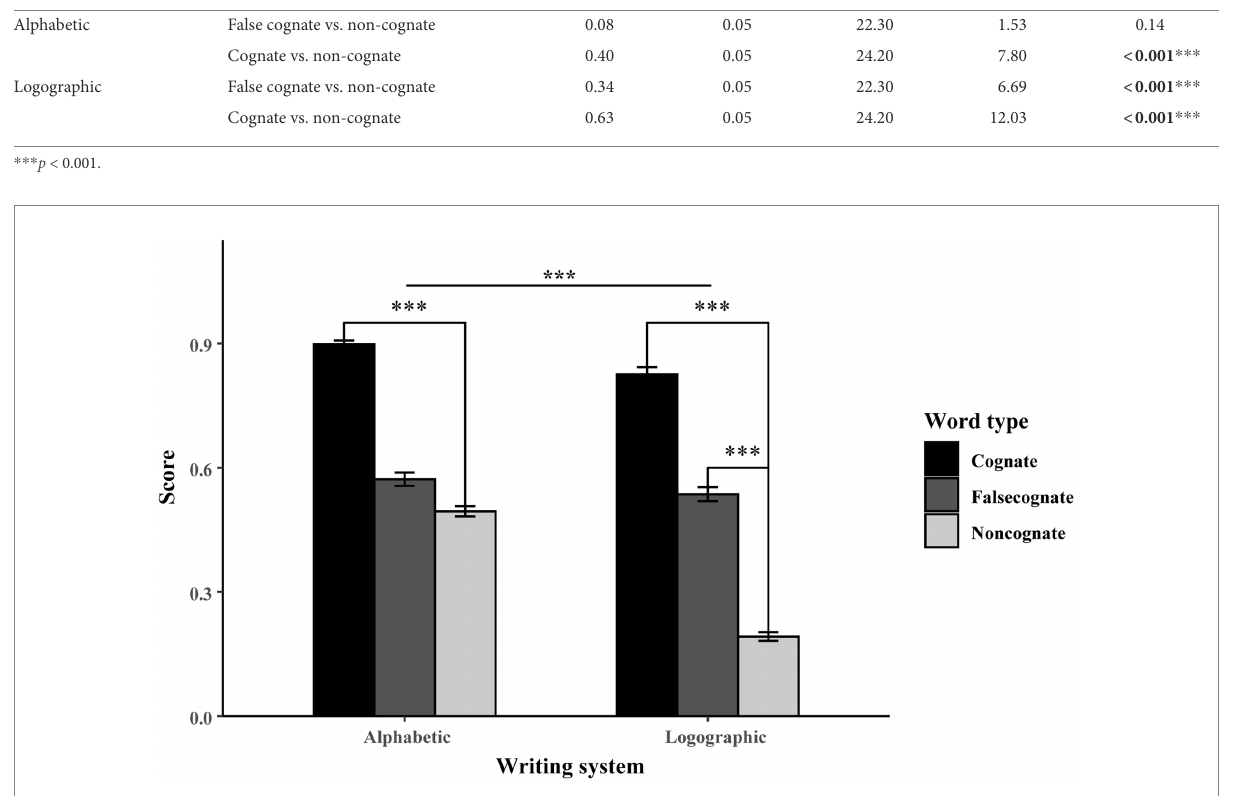
FIGURE 3 The alphabetic and logographic score for the cognate, false cognate and non-cognate in the production